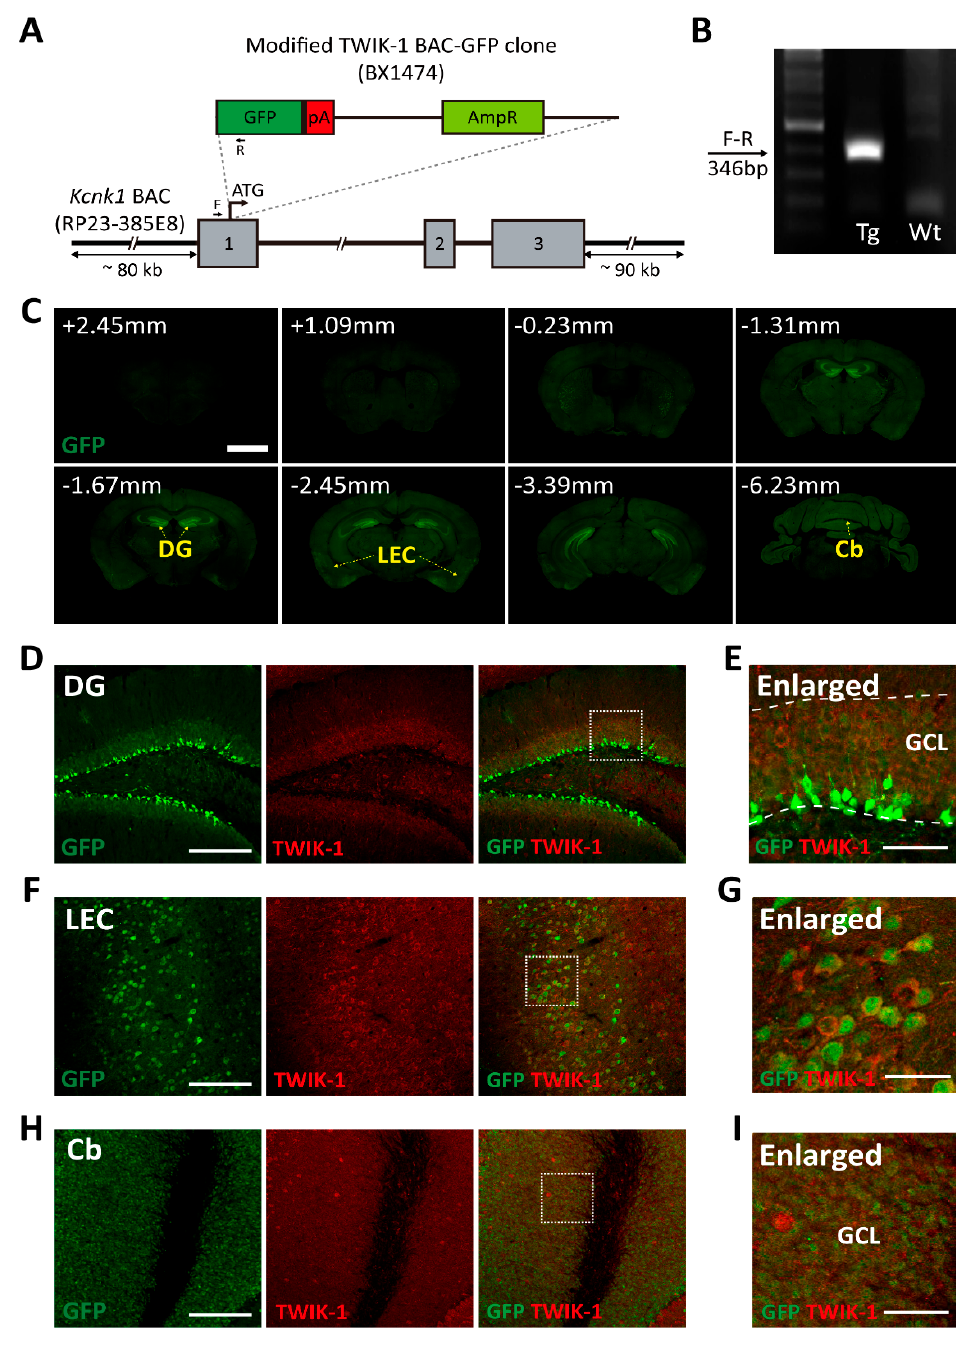
Figure 1. Generation of TWIK-1 BAC-GFP Tg mice. ( A ) Schematic design of the modified Kcnk1 BAC vector. GFP coding sequence was inserted just before the start codon of Kcnk1 . ( B ) Genotype PCR results for the designed primer pair in A. ( C ) Representative macroscopic GFP fluorescent images in the adult brain (P56 age) from TWIK-1 BAC-GFP Tg mice. Upper left numbers indicate the relative position of the brain slice from bregma. Strong GFP expression was identified in DG, LEC, and Cb (yellow dashed arrow), Scale bar, 1000 μ m. ( D ) Representative co-immunofluorescence images with GFP and TWIK-1 in the DG. Scale bar, 200 μ m. ( E ) Enlarged inset from D. Scale bar, 50 μ m. ( F ) Representative co-immunofluorescence images with GFP and TWIK-1 in the LEC. Scale bar, 200 μ m. ( G ) Enlarged inset from F. Scale bar, 50 μ m. ( H ) Representative co-immunofluorescence images with GFP and TWIK-1 in the Cb. Scale bar, 200 μ m. ( I ) Enlarged inset from H. Scale bar, 50 μ m.